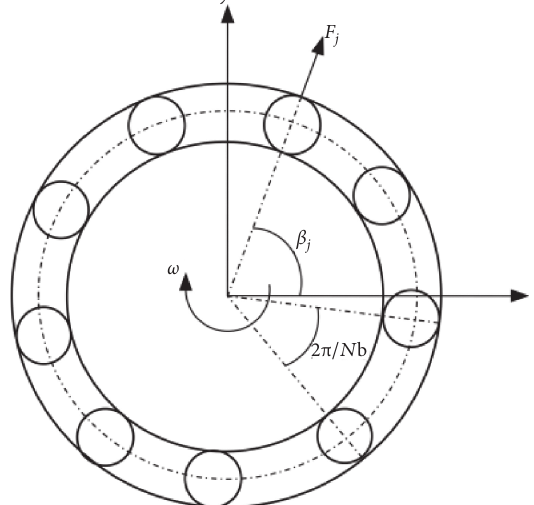
Figure 4: Schematic diagram of the rolling bearing system.